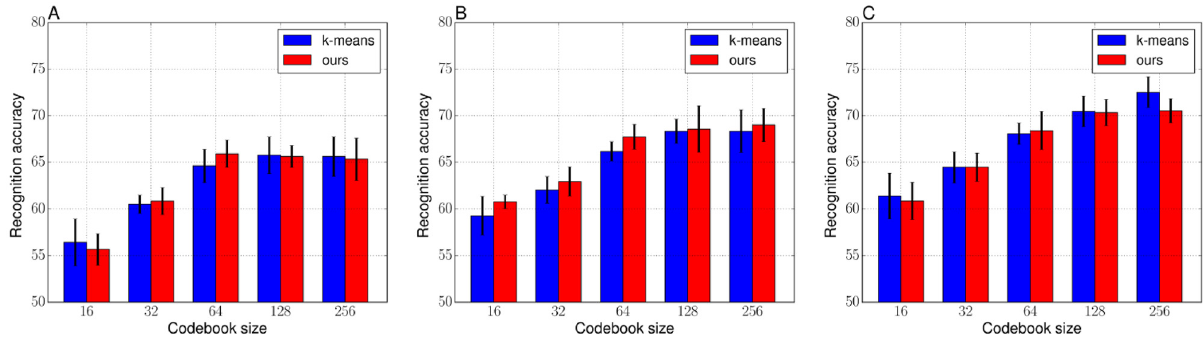
Fig 4. Recognition accuracies of the VLADs with the k-means and ours (hard objective) codebooks on the Birds. (A) 30 images per category for training. (B) 40 images per category for training. (C) 50 images per category for training.